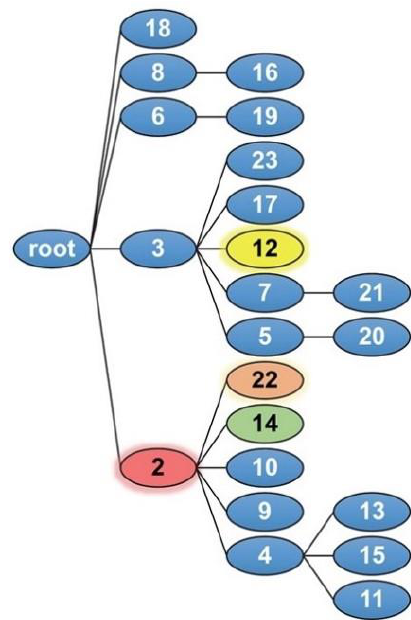
Figure 3. Sema4A and Sema4D compete for Plexin B1 binding in the in vitro ELISA assay. The HIS- Select nickel-coated microplates were covered with 10 μg/mL of Plexin B1 with His tag in Tris Buffer overnight. Either rhSema4A-GST or -Fc or rhSema4D-Fc in duplicates were applied to the plates in varying doses starting from 2 μg/mL . ( A ) rhSema4D binding to Plexin B1 in the direct LRA ELISA. ( B ) Inhibition of 2 μg/mL Sema4D binding to Plexin B1 by increasing concentrations of Sema4A, starting at 2 μg/mL dose. The OD for Sema4A+Sema4D was compared to the corresponding OD for Sema4D alone in the wells covered with Plexin B1 protein.